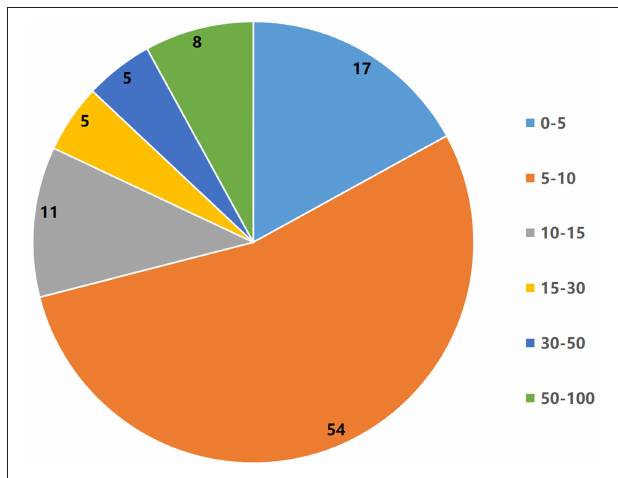
FIGURE 6 | The number of articles corresponding to different impact factors in the top 100 most-cited